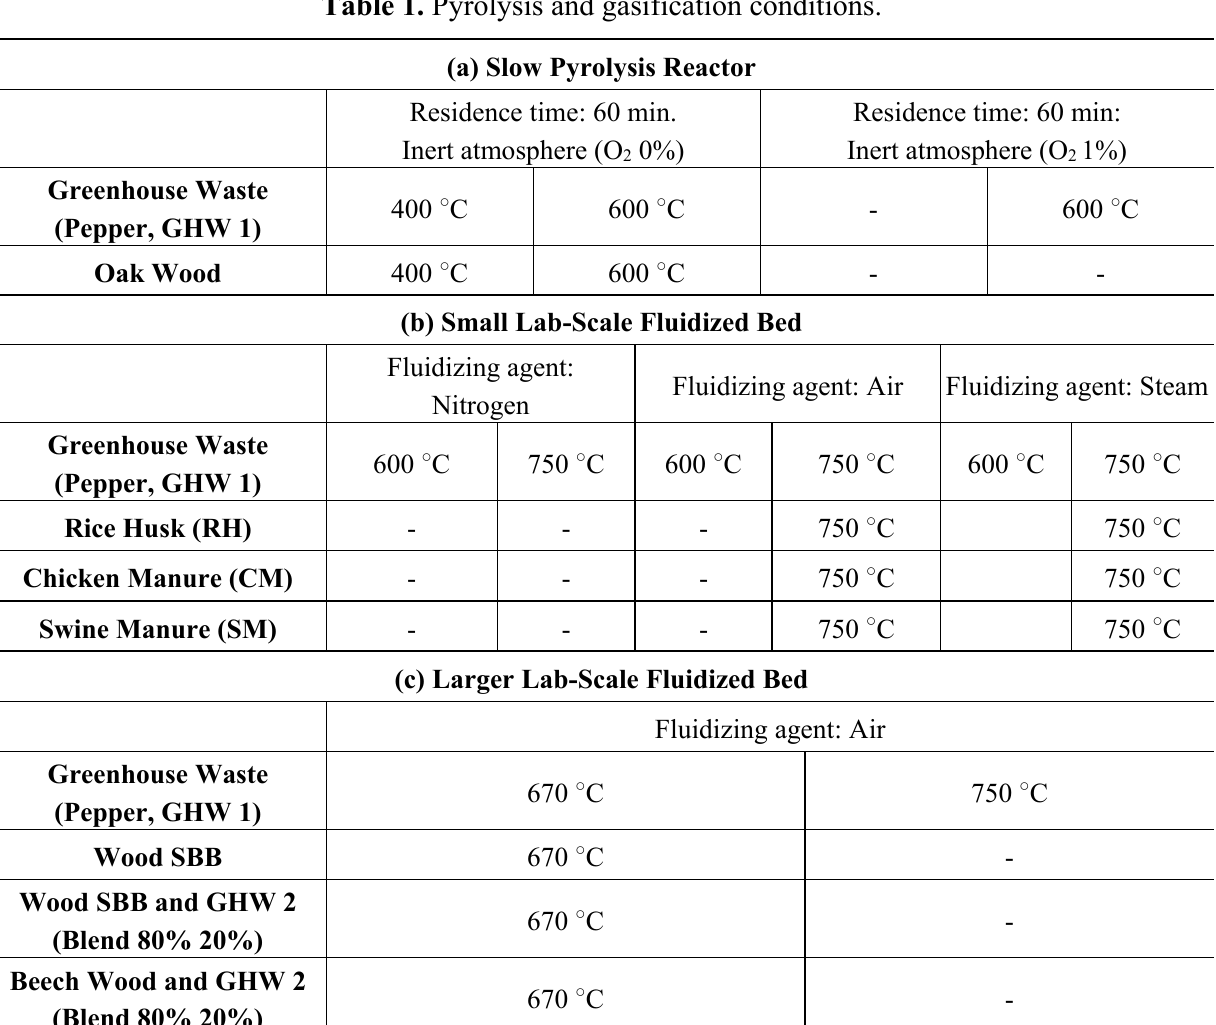
Table 1. Pyrolysis and gasification